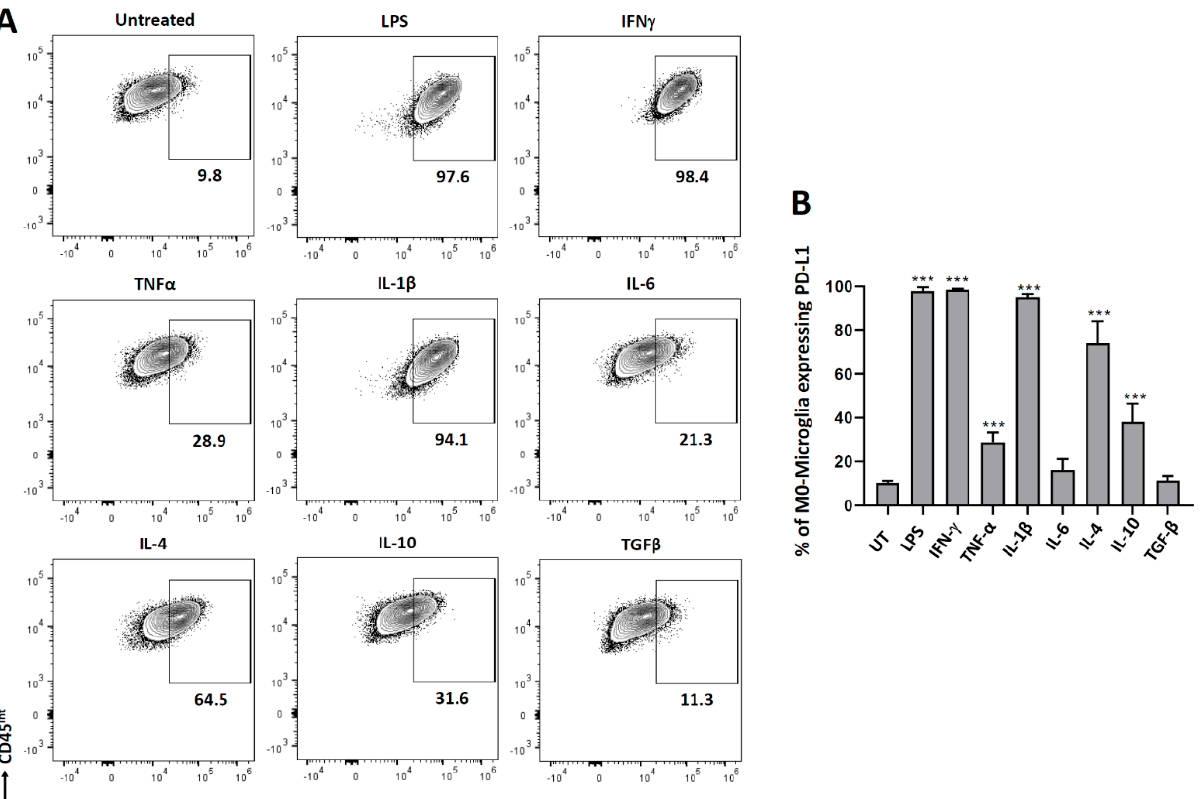
Figure 1. PD-L1 expression on non-polarized (M0) microglial cells. Microglia were isolated from 7-10 d old pups using the Miltenyi mouse adult dissociation kit followed by CD11b isolation. Cells were treated with various pro- and anti-inflammatory mediators for 24 h and then trypsinized to stain for PD-L1. ( A ) Representative contour plots showing microglial cells (CD45 int ) expressing PD-L1. ( B ) Graphical representation of microglial cells expressing PD-L1 after 24 h of treatment. UT-untreated control. Experiments were carried out three times with duplicate wells and presented as mean ± SE. *** p < 0.001.